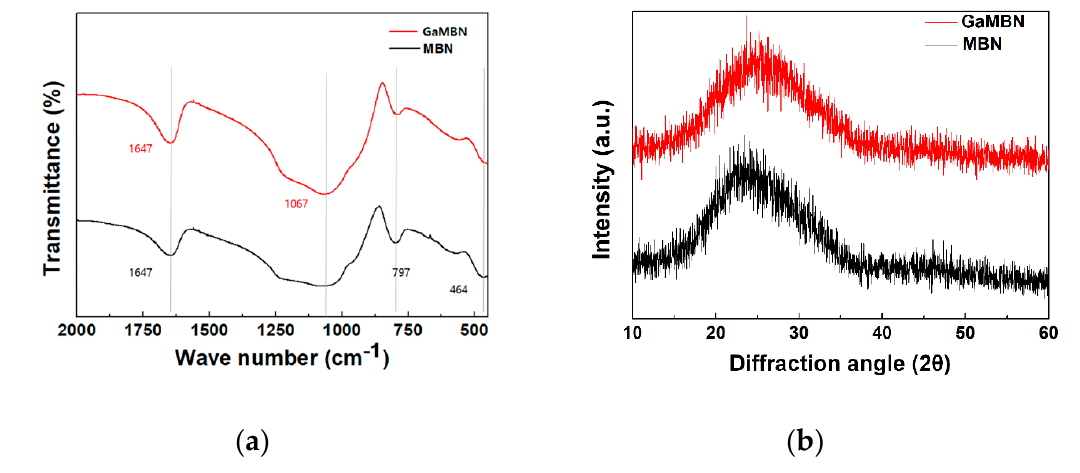
Figure 3. ( a ) FTIR and ( b ) XRD spectra of MBN and GaMBN.